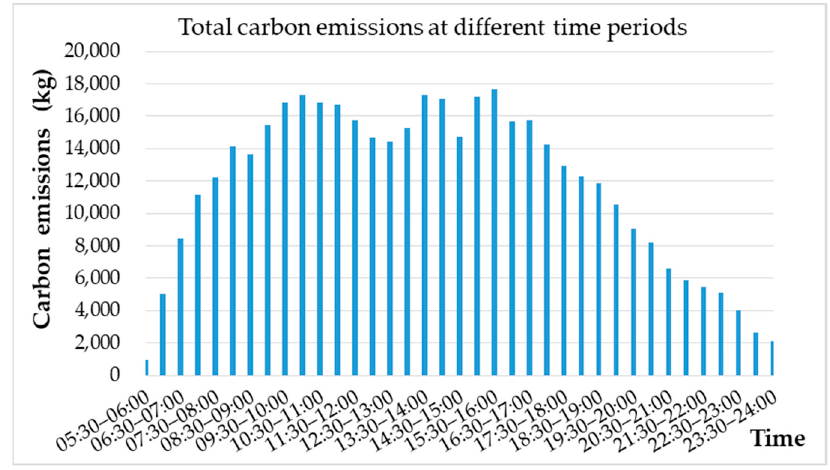
Figure 3. Time span of the emissions for the buses in Sanya.